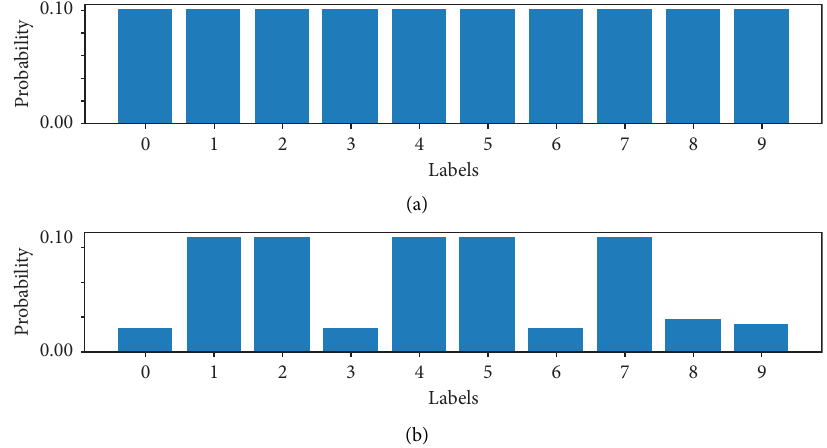
Figure 5: The difference between two sets. (a) The probability of the training set. (b) A case of local probability.